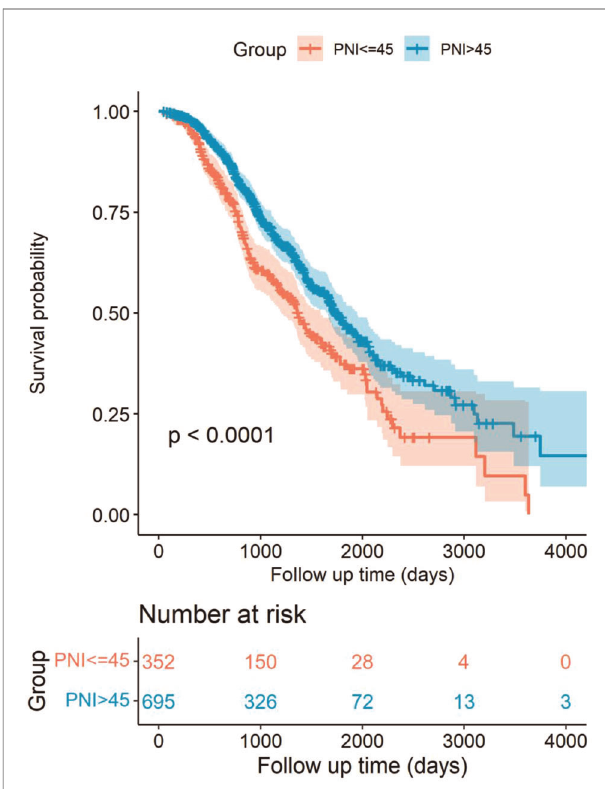
FIGURE 2 | Kaplan – Meier survival curves comparing HCC patients within Milan criteria after US-PMWA with low PNI and high PNI groups.